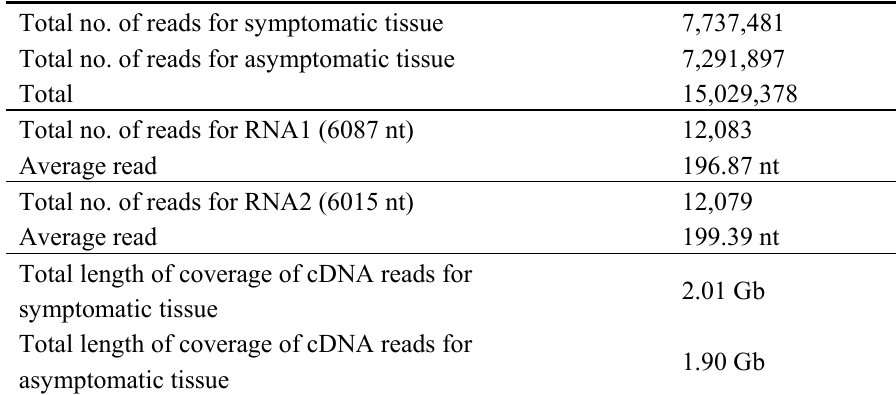
Table 1. Reads of symptomatic and asymptomatic